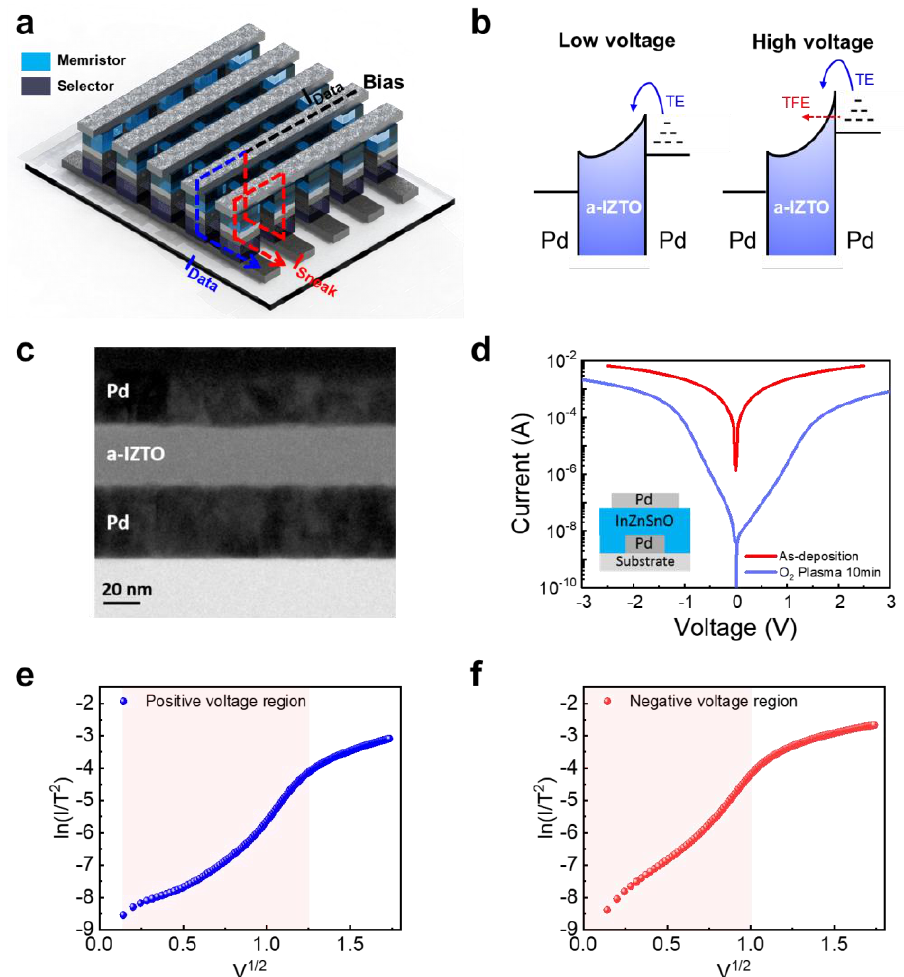
Figure 1. ( a ) Schematic of the sneak current path in memristor crossbar array during operation. ( b ) Band diagram and conduction mechanism of back-to-back Schottky diode under low- and high-voltage regions. ( c ) Cross-sectional HRTEM image of the a-ITZO-selector device. ( d ) I – V characteristics of a-ITZO-selector device before and after O 2 plasma treatment prior to deposition of top Pd electrode. The results of the I-V characteristics are fitted by thermionic emission in ( e ) the positive-voltage region and ( f ) the negative-voltage region. The shaded red regions are the thermionic emission region where the current increases exponentially with the voltage on a linear scale.